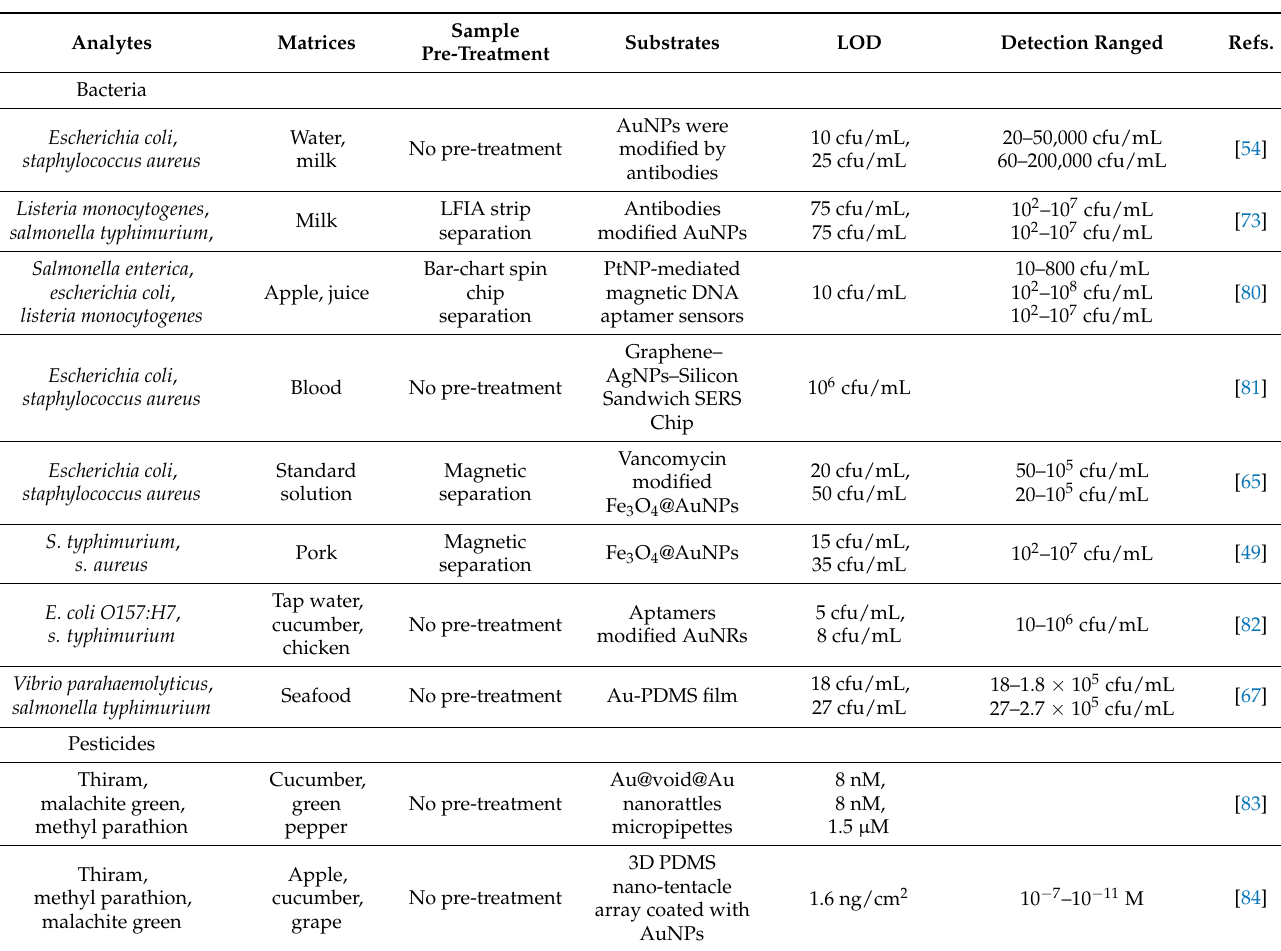
Table 1. Multiple food contaminants in different matrices simultaneously detected by